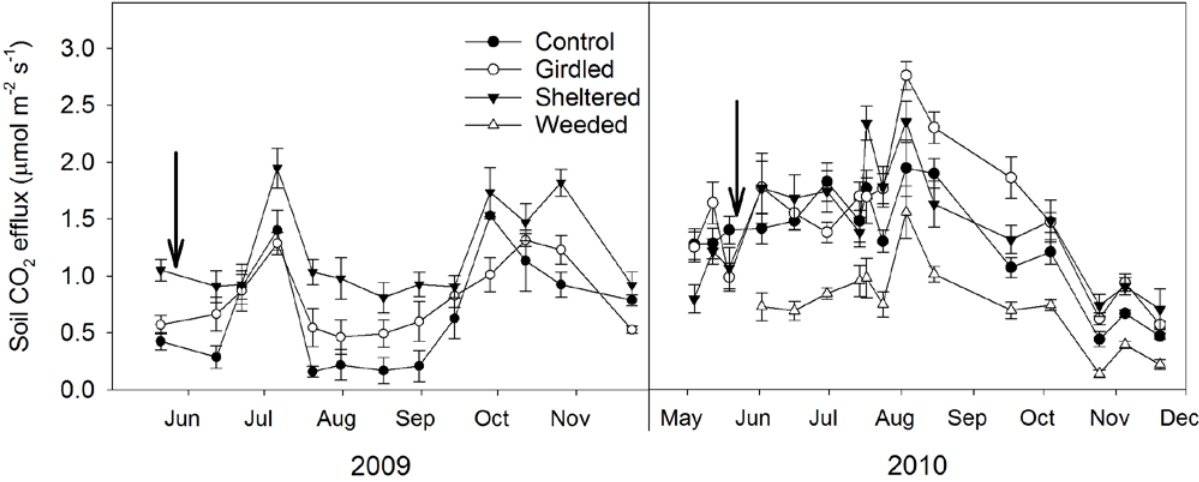
Figure 3. Soil CO 2 efflux (µmol m -2 s -1 ) during the study periods in 2009 (left) and 2010 (right). Data are for the snow-free period of each year only. Arrows indicate when girdling took